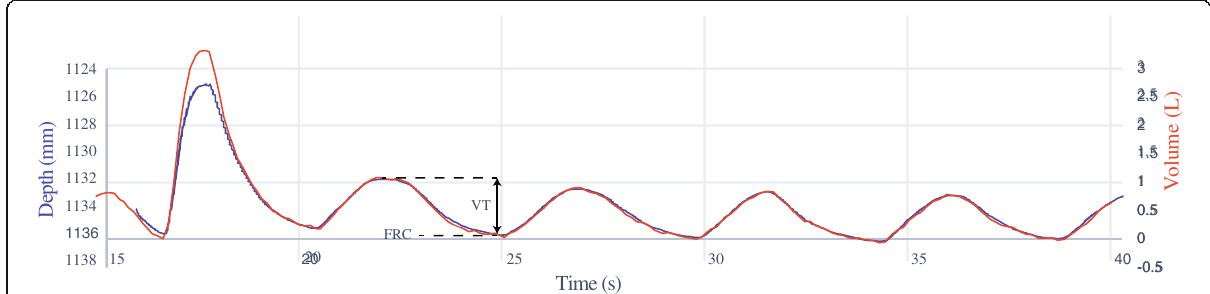
Fig. 6 Prone position. Superimposed graphs of mean depth, measured by the Kinect ( blue , left axis) and volume, measured with spirometry ( red , right axis) of a volunteer in prone position. Periods of breath-hold are indicated with grey boxes . FRC functional residual capacity, VT tidal volume